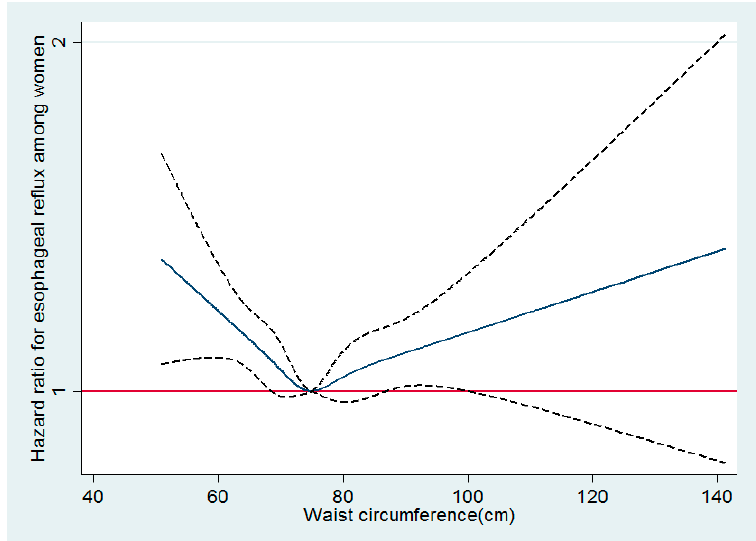
Figure 2. Multivariable-adjusted hazard ratios for reflux esophagitis by waist circumference among women. Curves represent adjusted hazard ratios for reflux esophagitis based on restricted cubic splines with knots at the 5th, 27.5th, 50th, 72.5th, and 95th percentiles of waist circumference. Models were adjusted for age, center, year of screening exam, smoking status, alcohol intake, physical activity, education level, history of diabetes, medication for diabetes, history of hypertension, medication for hypertension, and medication for dyslipidemia. The red solid line represents the reference plane; the navy solid line represents hazard ratio; and the black dotted lines represent 95% confidence intervals. Table 4. Development of reflux esophagitis according to abdominal obesity and waist circumference quartiles within normal range by sex.